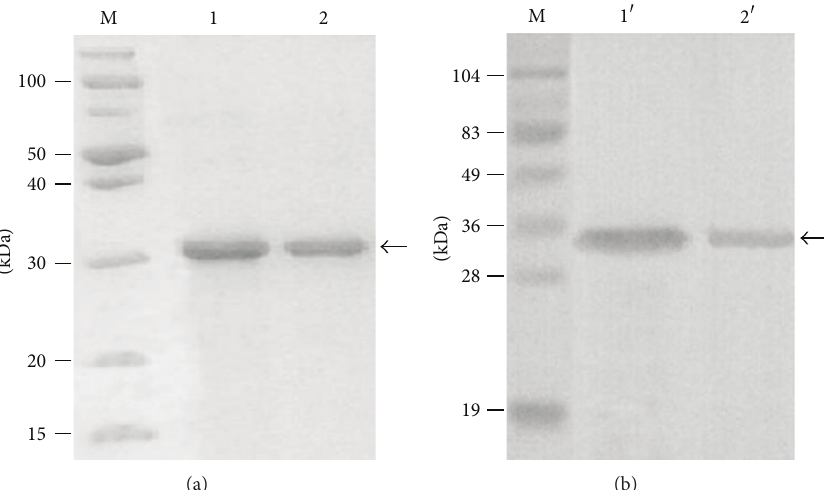
Figure 4: Identification of the recombinant Slp and Lsp-t proteins by SDS-PAGE (a) and Western blot (b). M represents the protein molecular weight marker. Lane 1 represents the purified recombinant Slp, and lane 2 represents the purified recombinant Lsp-t proteins by SDS-PAGE analysis.Lanes1 󸀠 and2 󸀠 representthepurifiedrecombinantSlpandLsp-tproteinsasdeterminedbyWesternimmunoblottinganalysis.Arrows indicate the target